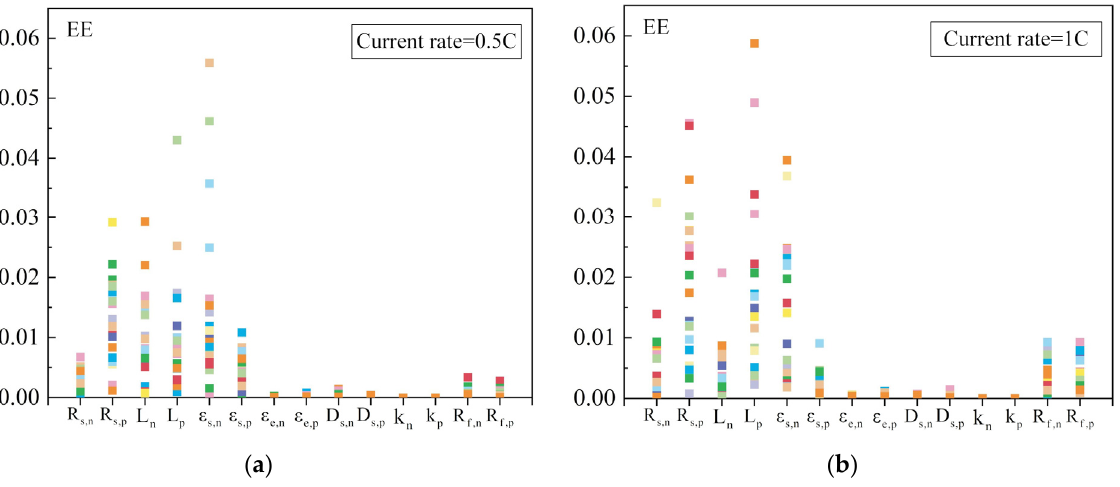
Figure 6. Elementary test result of 14 electrochemical parameters of ICR18650-26J ba tt ery under C-rates at ( a ) 0.5C and ( b ) 1C. Table 5. Parameter identi fi cation results.